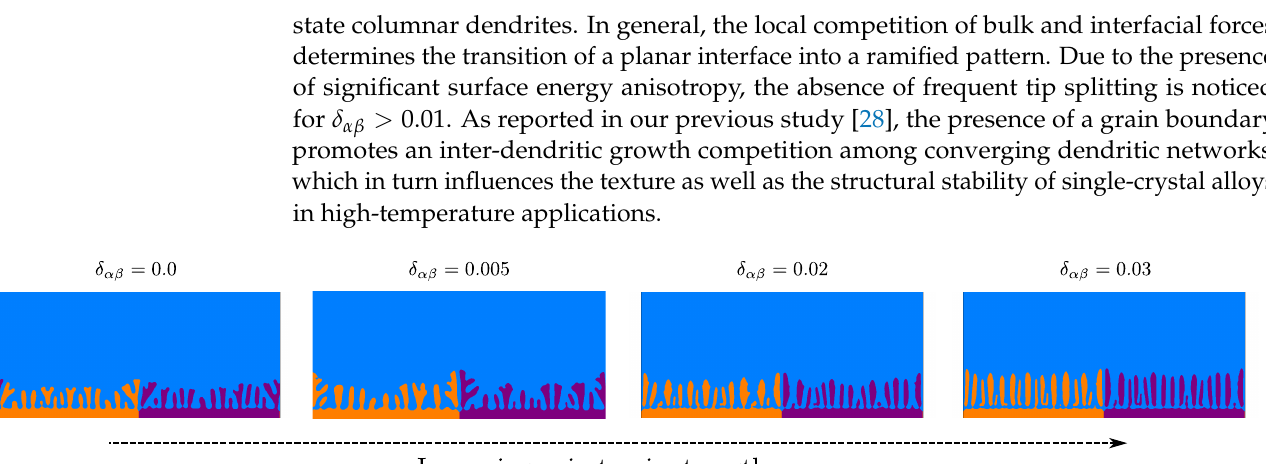
Figure 5. Reconstructed simulation screenshots illustrating the role of interfacial anisotropy on pattern formation. With an increase in the anisotropic strength δ αβ , the tip-splitting microstructure translates into an array of columnar